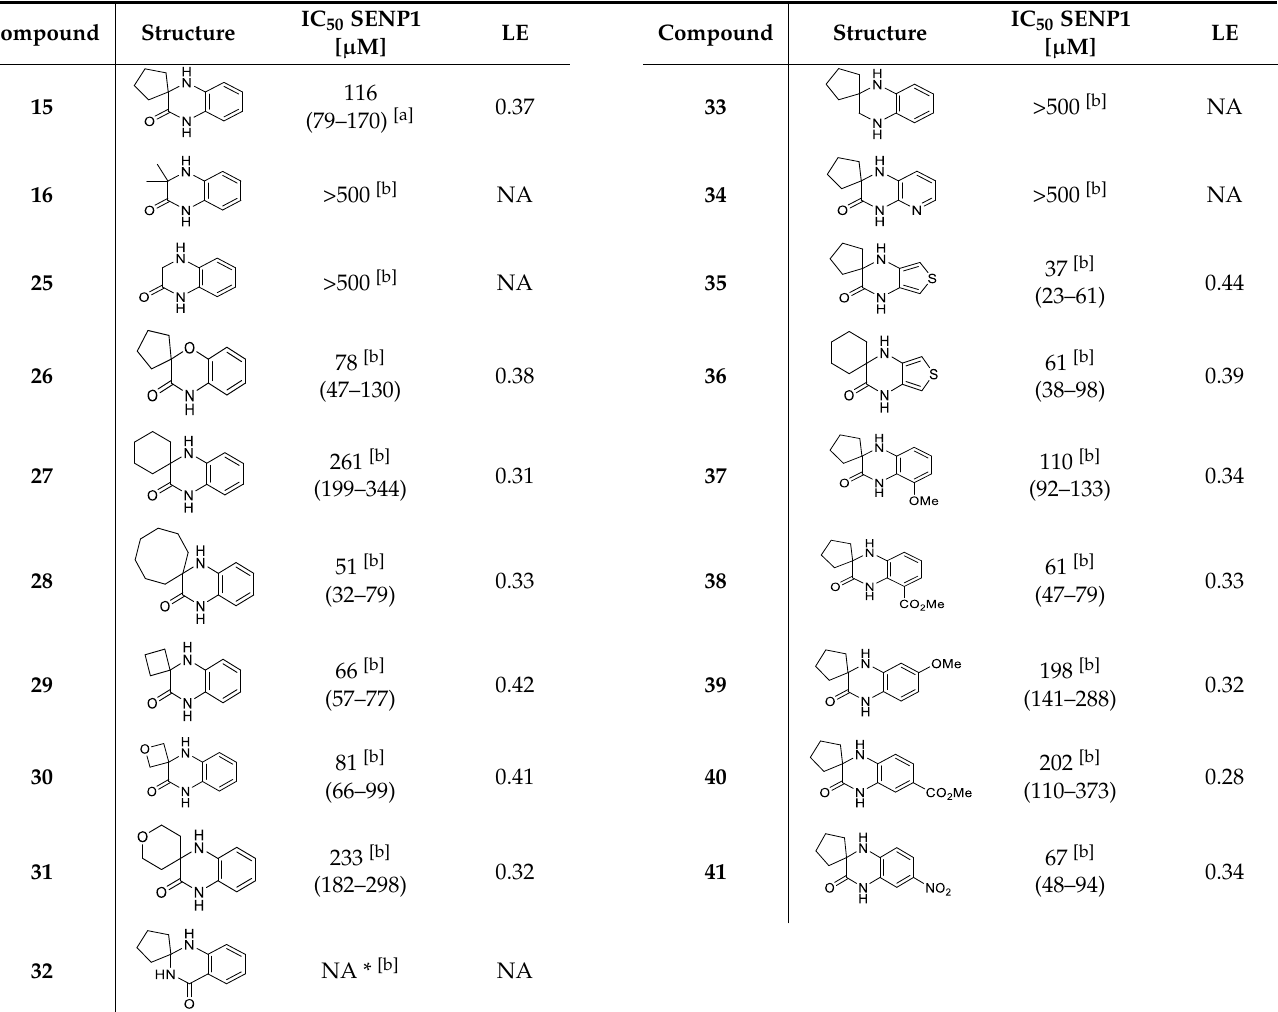
Table 2. List of the synthesized fragments ( 15 , 16 , 25 – 41 ). LE = ligand efficiency (calculated: 1.4(- log IC 50 )/N) [30]; (a) n = 4, (b) n = 2. * Compound is fluorescent at c > 10 μM; NA = not applicable.